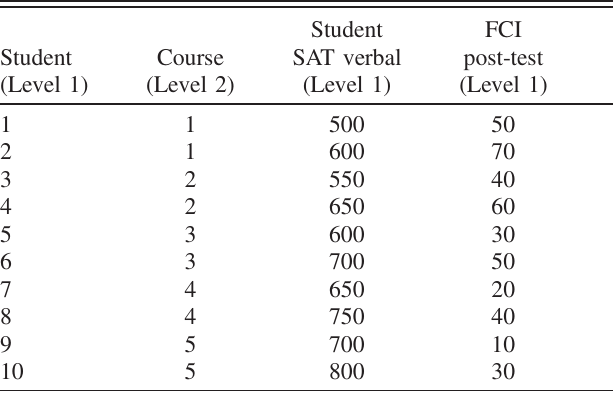
TABLE II. Sample multilevel